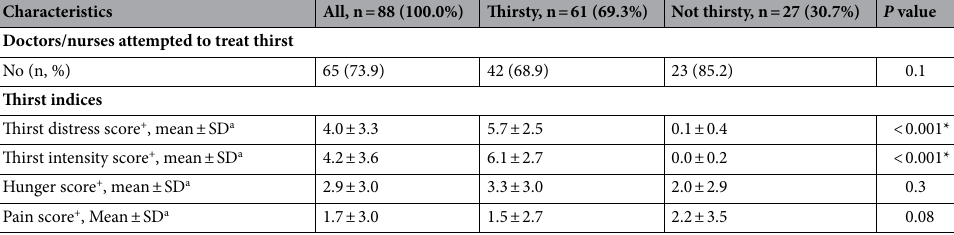
Table 2. Predictors of Thirst. * P < 0.05. a SD: Standard deviation. b PPI: Proton Pump Inhibitor. c NSAID:Non- steroidal anti-inflammatory drugs. d IQR: inter-quartile range. + scored 0 to 10, 10 being most